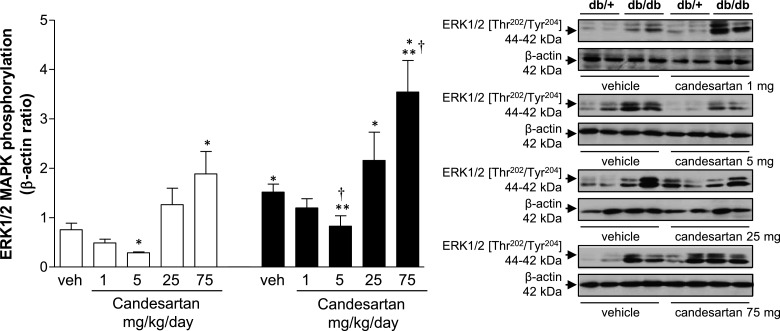
High and ultra-high doses of candesartan increase renal ERK1/2 phosphorylation in db/db micePhosphorylation levels of ERK1/2 in kidney cortex from db/+ and db/db mice treated with vehicle or candesartan (1, 5, 25 or 75 mg/kg/d). Side panels, representative immunoblots of ERK1/2 [Thr202/Tyr204] and β-actin. Results are presented as mean ± S.E.M. of 5–7 mice. *P<0.05 compared with vehicle-treated db/+; **P<0.05 db/db compared with db/+ of corresponding candesartan dose; †P<0.05 candesartan-treated db/db compared with vehicle-treated db/db.